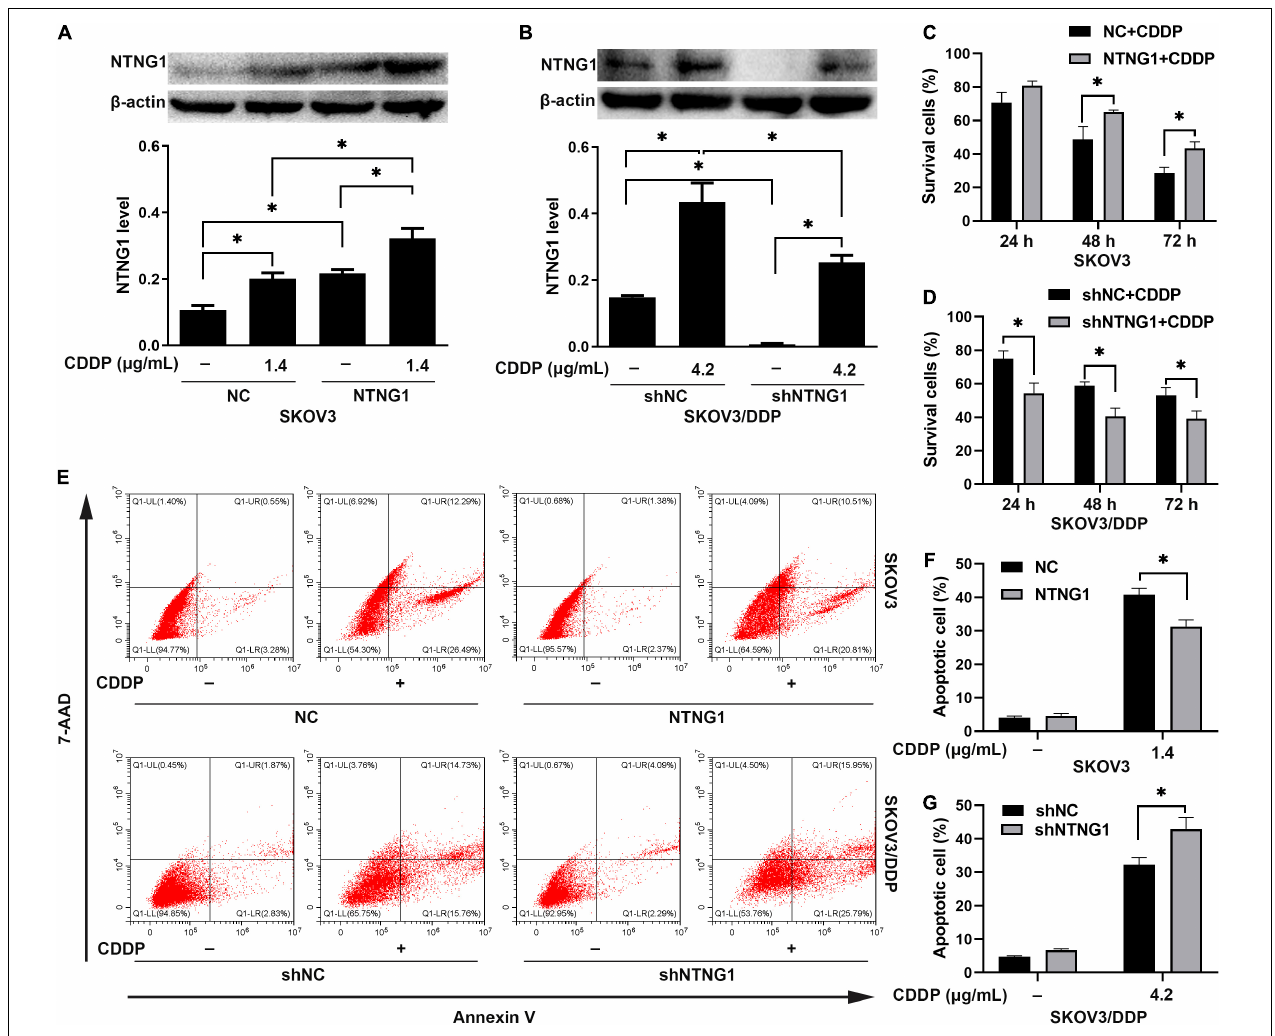
FIGURE 3 | NTNG1 enhanced the action of cisplatin in vitro ( n = 3). (A,C) The level of NTNG1 was increased in NTNG1-transfected SKOV3 cells; overexpression of NTNG1 increased the cell-survival percentage following cisplatin exposure. (B,D) The NTNG1 level was decreased in shNTNG1-transfected SKOV3/DDP cells; silencing NTNG1 decreased the cell-survival percentage following cisplatin treatment. (E–G) Apoptosis induced by cisplatin; the percentage of apoptotic SKOV3 cells decreased following overexpression of NTNG1, but increased in SKOV3/DDP cells after silencing NTNG1. CDDP, cisplatin. ∗ p <